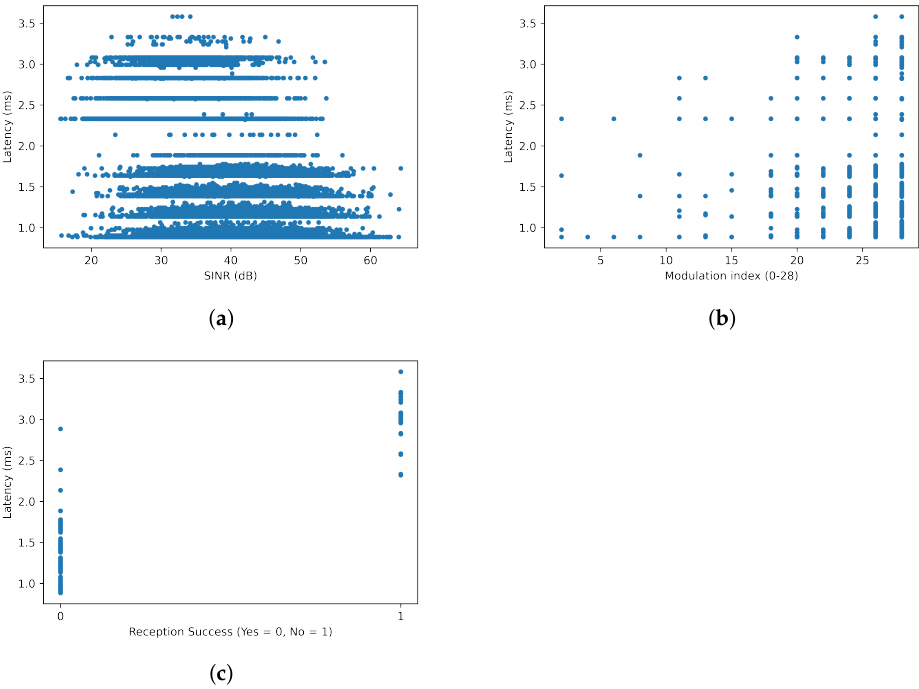
Figure 5. Latency samples. ( a ) SINR, ( b ) Modulation index and ( c ) Reception Success.